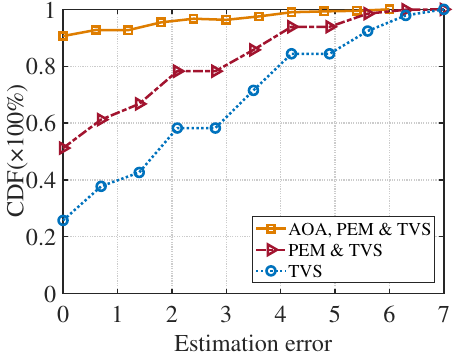
Figure 11. CDF of the estimation error of different features.